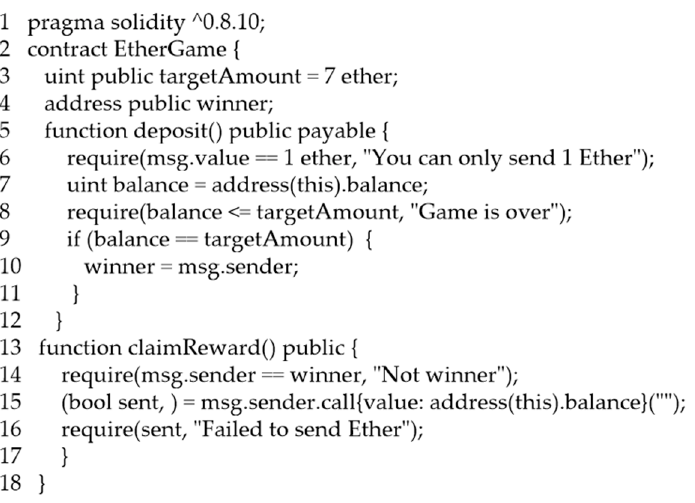
Figure 4. Self-destruct vulnerability